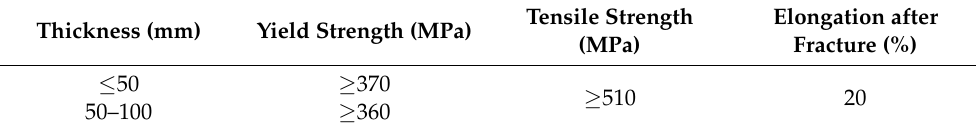
Table 2. The mechanical properties of Q370qD [26].